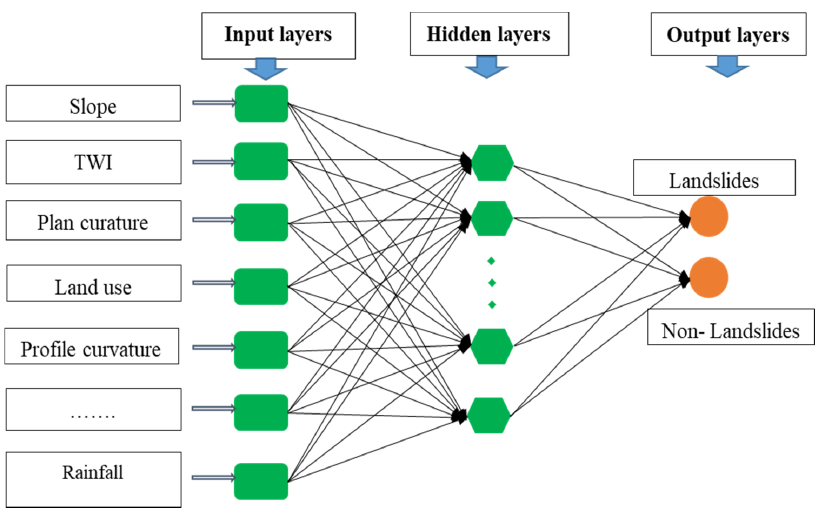
Figure 4. Flowchart of the Artificial Neutral Network (ANN) model.